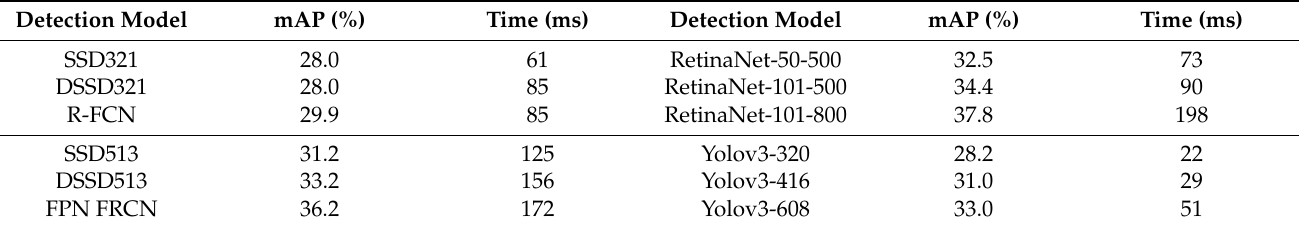
Table 2. The performance comparison of various real-time object detection models [19].